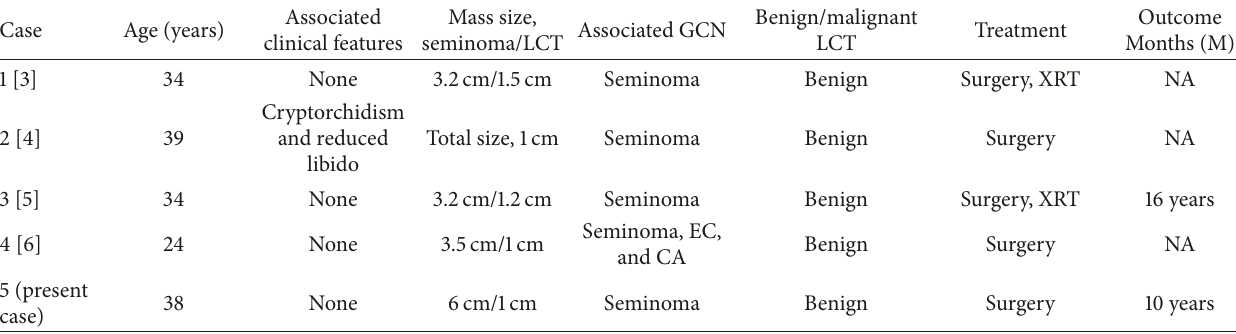
Table 1: Clinical summary of reported cases of synchronous Leydig cell tumor and seminoma in an ipsilateral